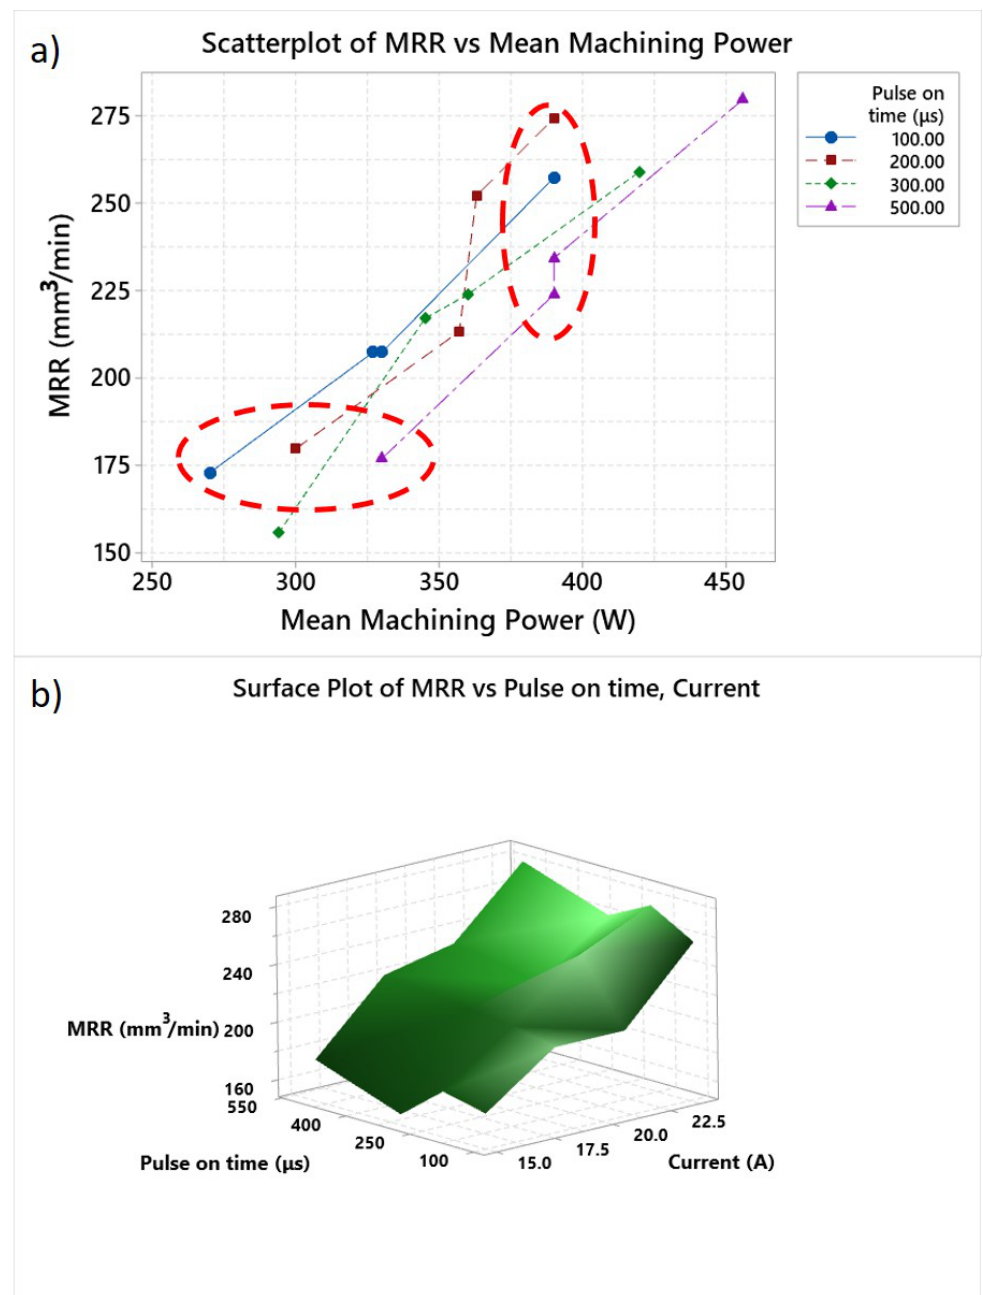
Figure 2. ( a ) MRR vs. mean machining power. ( b ) MRR vs. I P and T on .